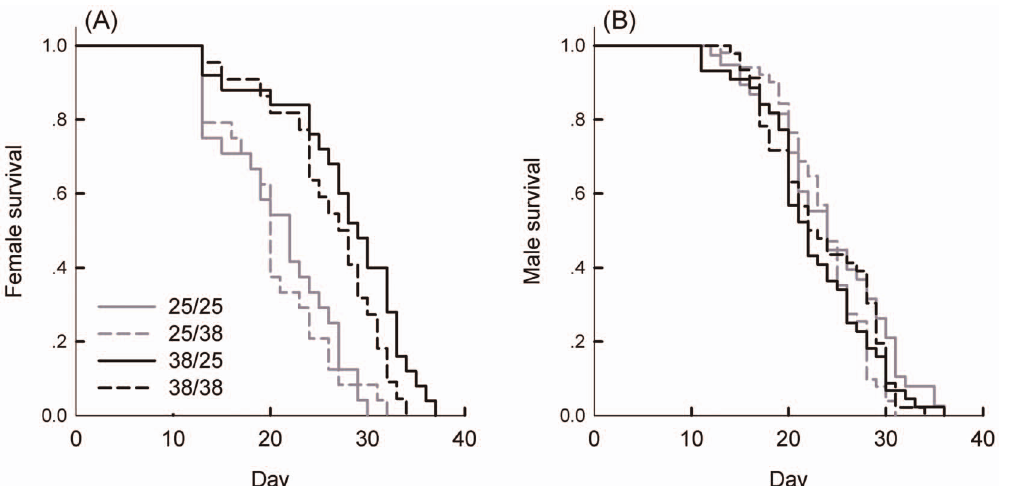
Fig. 1. Survival curves of females and males in G. molesta after different temperature treatments. Treatments involved different combinations of female and male exposure to either 25 ˚ C or 38 ˚ C for 4 h. 25/25: both males and females were kept at 25 ˚ C; 25/38: females were remained at 25 ˚ C but males were stressed at 38 ˚ C; 38/25: females were stressed at 38 ˚ C and males were remained at 25 ˚ C; 38/38: both females and males were stressed at 38 ˚